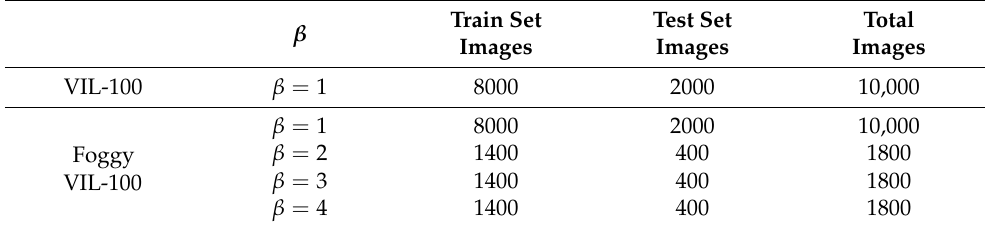
Table 8. Comparison between test sets of VIL-100 and FoggyVIL-100 ( β = 2, 3, 4 ) . Scenarios